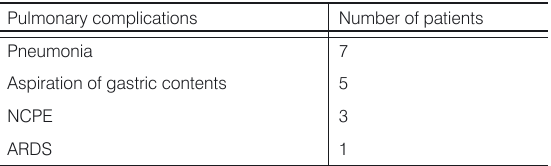
Table 1. Pulmonary